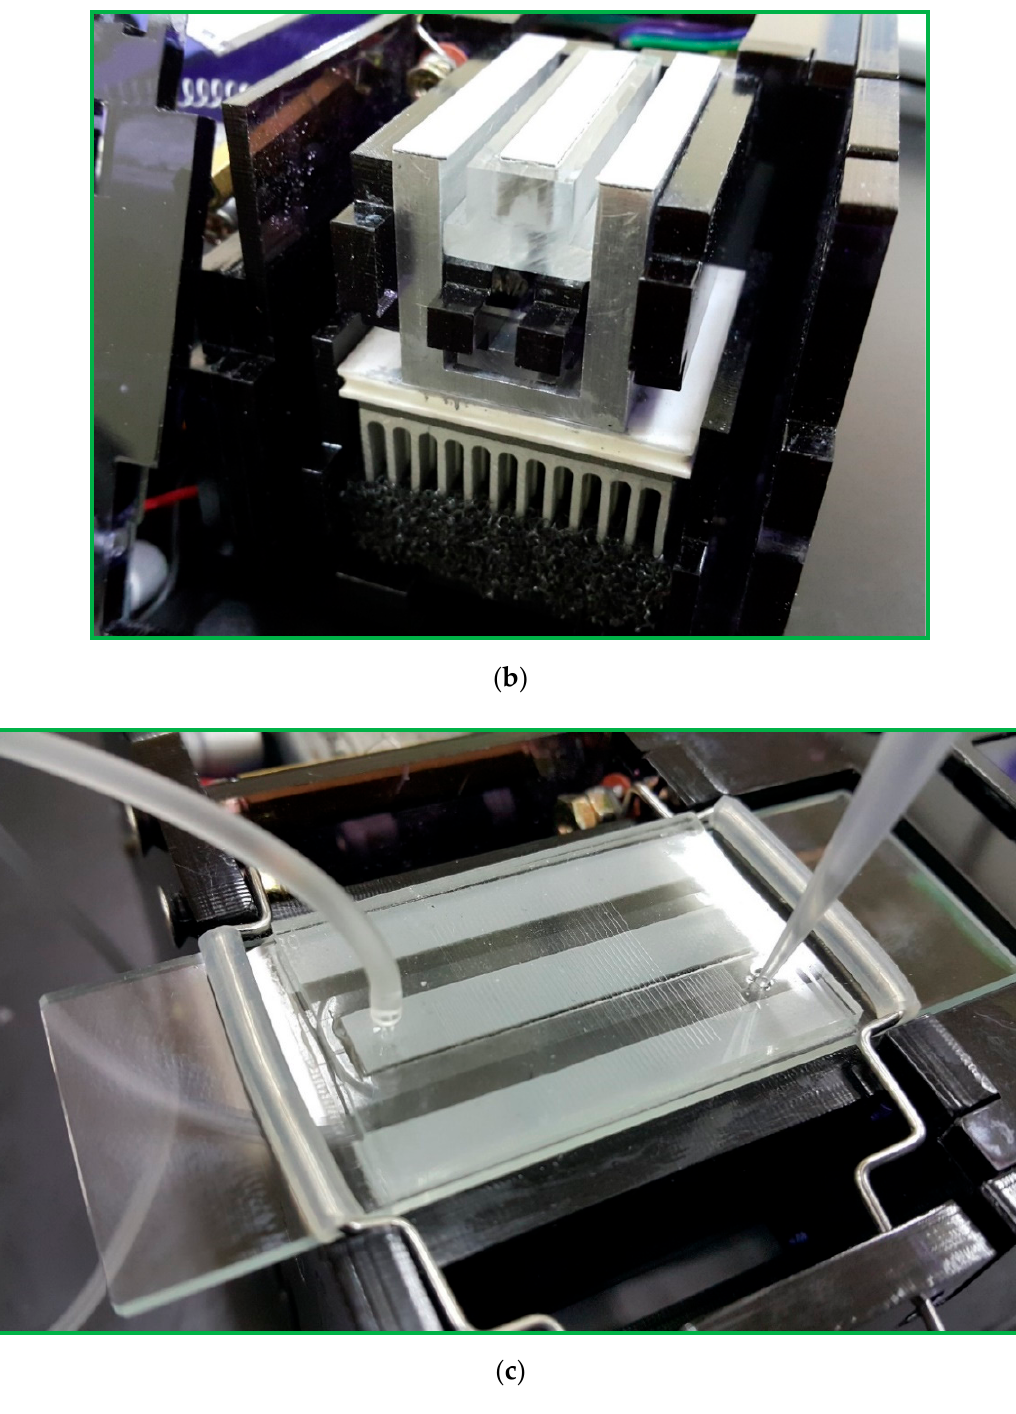
Figure 4. ( a ) The structure of the thermal cycling apparatus consists of a cartridge heater, a Peltier element, aluminum fins, and thermally conductive aluminum blocks. ( b ) The aluminum heating blocks and the PDMS-based chip are assembled and fixed onto a PMMA housing. ( c ) The five-temperature-region design requires only one half-loop per PCR cycle.